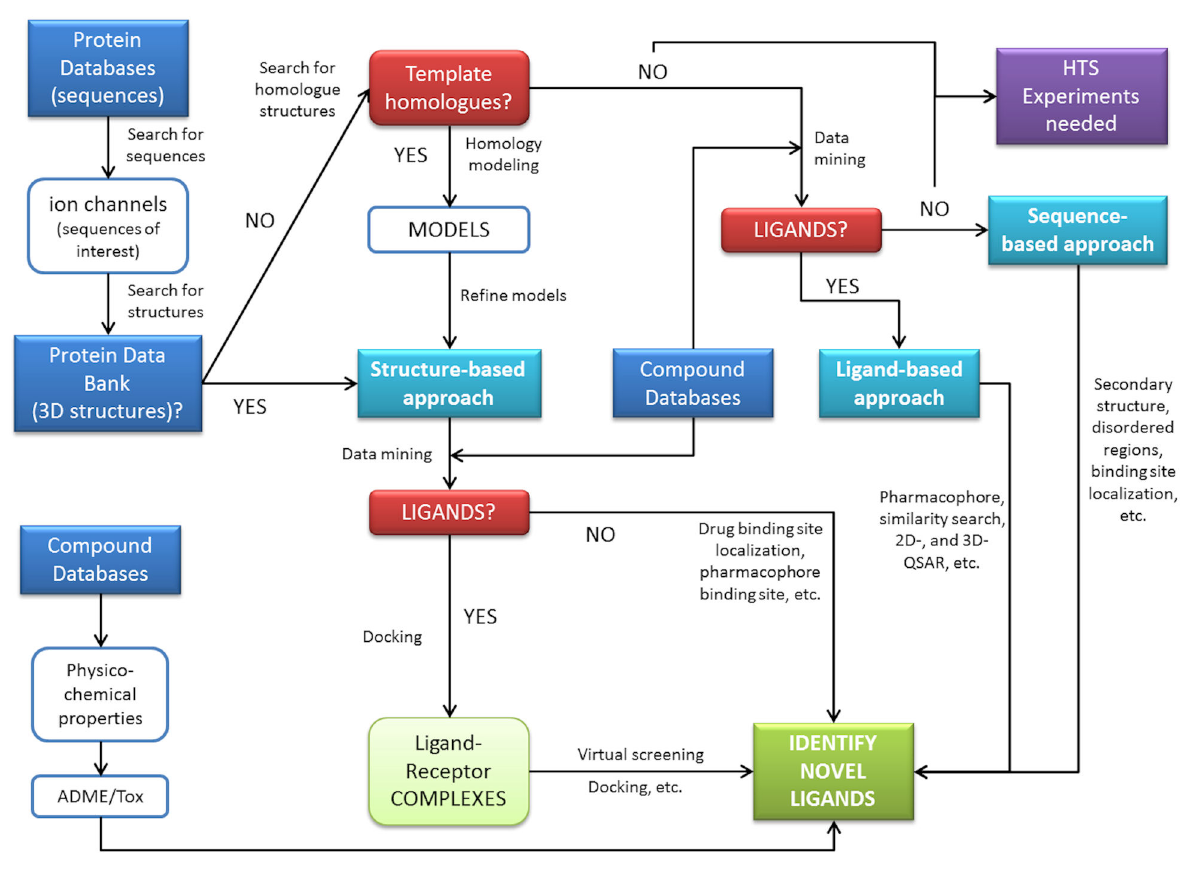
Figure 3. A schematic view of general procedures for in silico pharmacology. Three main procedures, structure-, ligand-, and sequence-based approaches are interconnected with databases for a general goal, the discovery of novel compounds to modulate